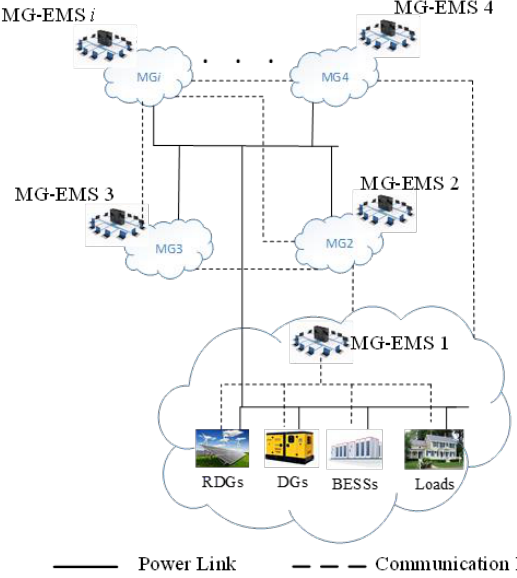
Figure 1. System model of the proposed multi-microgrid (MMG) network .